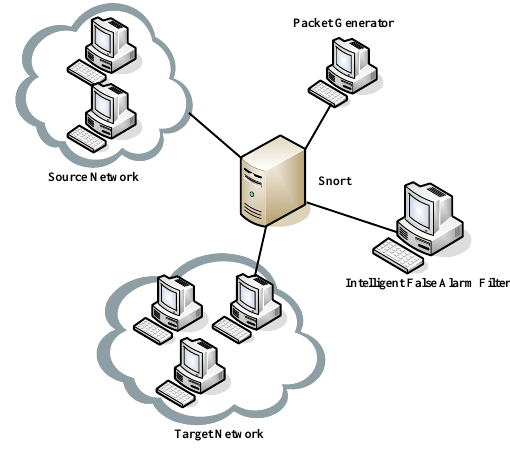
Fig. 5. The deployment of experimental